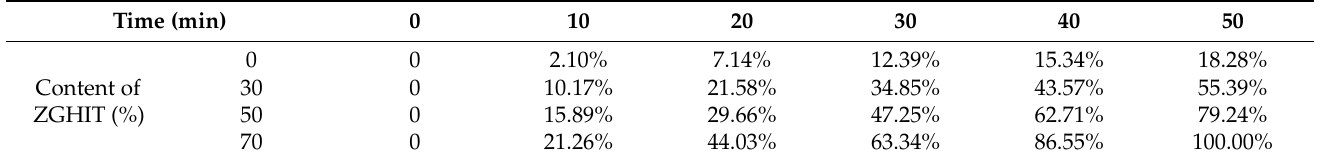
Figure 9. Ice-melting rate of specimens with different content of deicing agent. Figure 9. Ice ‐ melting rate of specimens with different content of deicing agent. Table 4. Ice-melting rate of deicing Table 4. Ice ‐ melting rate of deicing specimens.